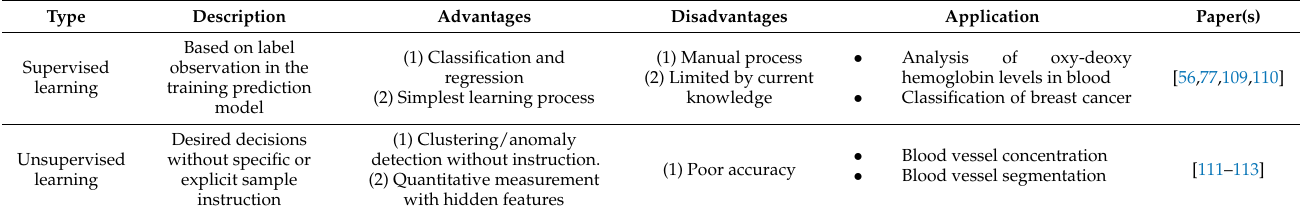
Table 2. Deep learning projects facilitating PAI segmentation and